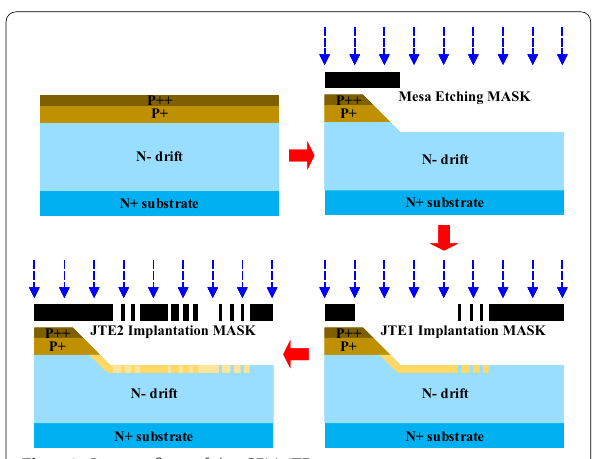
Fig. 10 Process flow of the CFM‑JTE